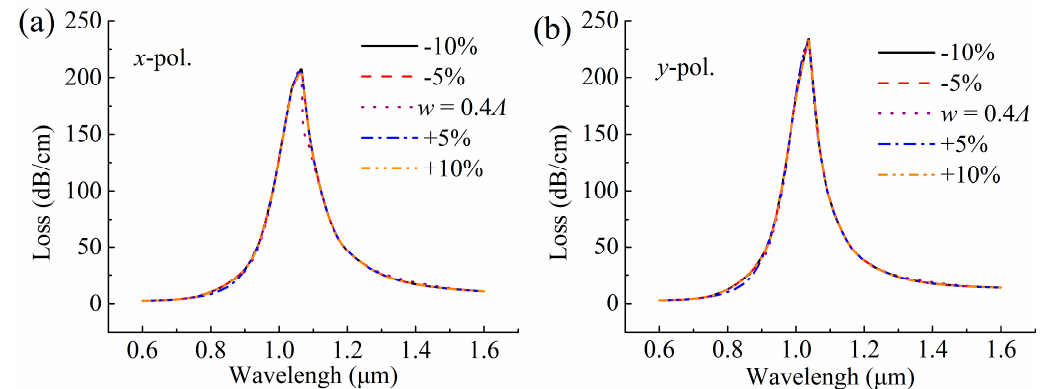
Figure 7. Losses as a function of wavelength for the ( a ) x -polarized and ( b ) y -polarized core modes at n = 1.47, with varying width of the slot ( w ).